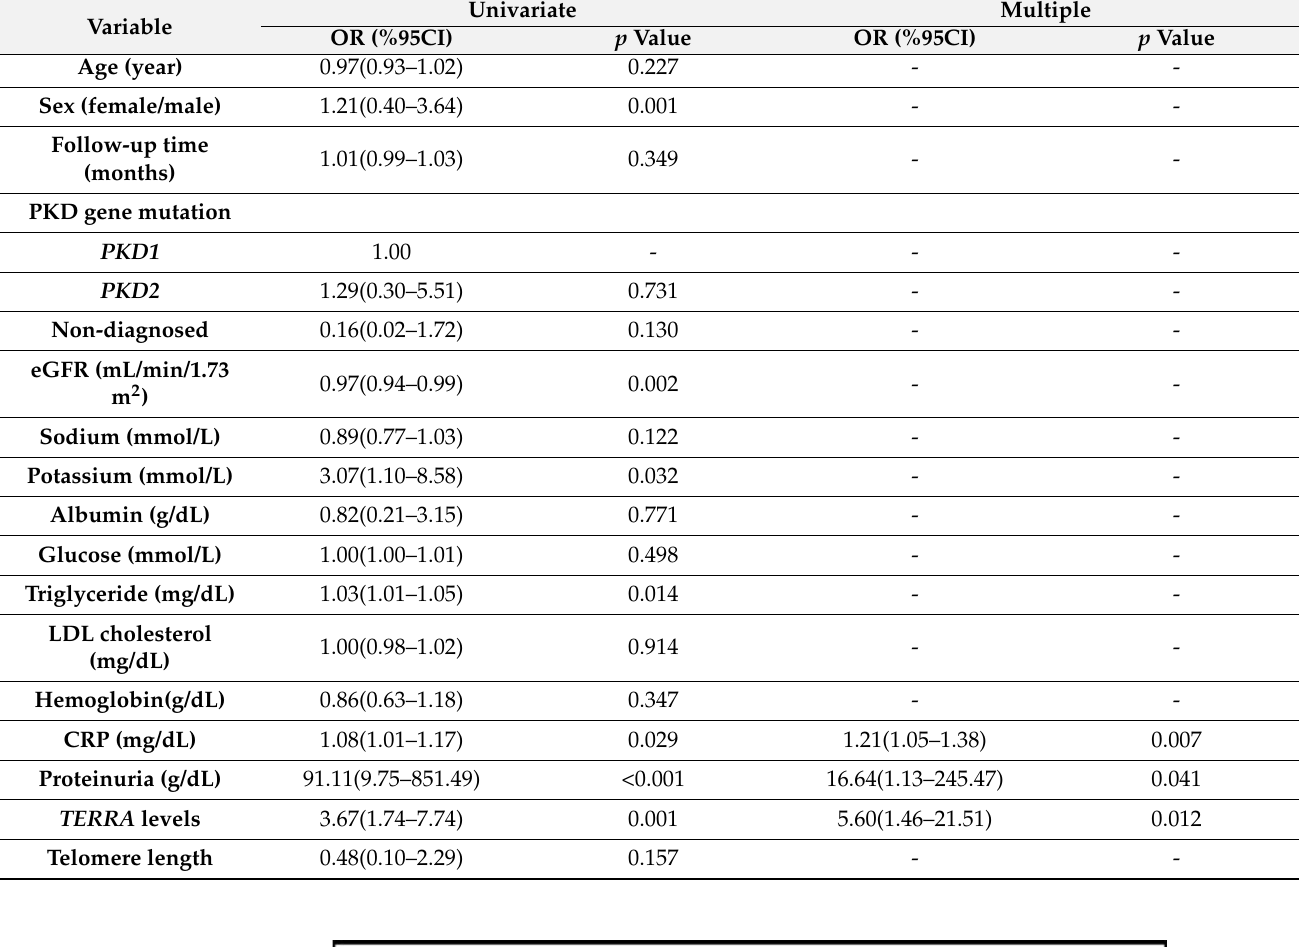
Table 4. Results of binary logistic regression analyses to predict rapid progression in ADPKD patients. OR: odds ratio, CI: confidence interval. Significant p values are shown in bold.